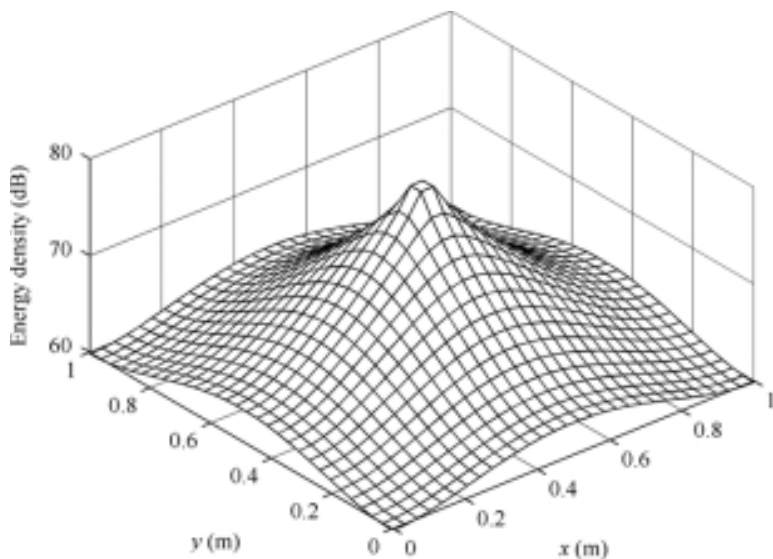
Fig. 19. The approximate energy density distribution of the isotropic plate when f = 1 kHz and η = 0 . 2 . The reference energy density is 1 × 10 − 12 J/m 2 .